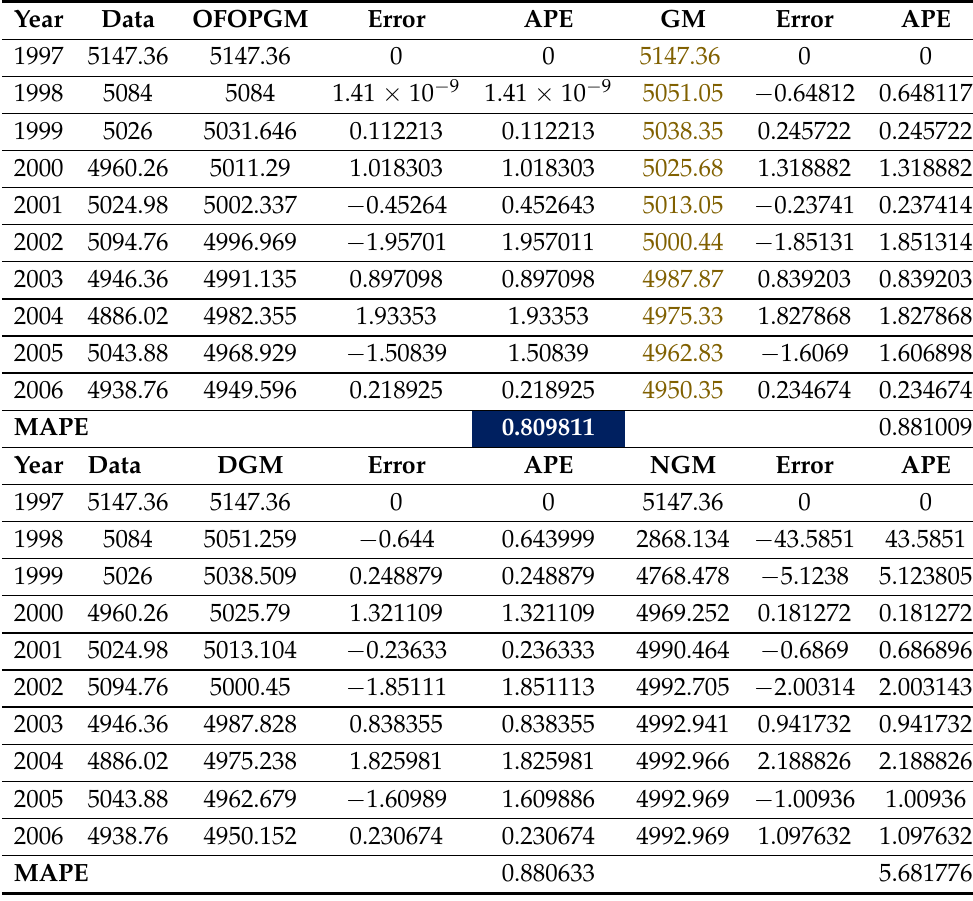
Table 3. Energy Generation Forecast [25].